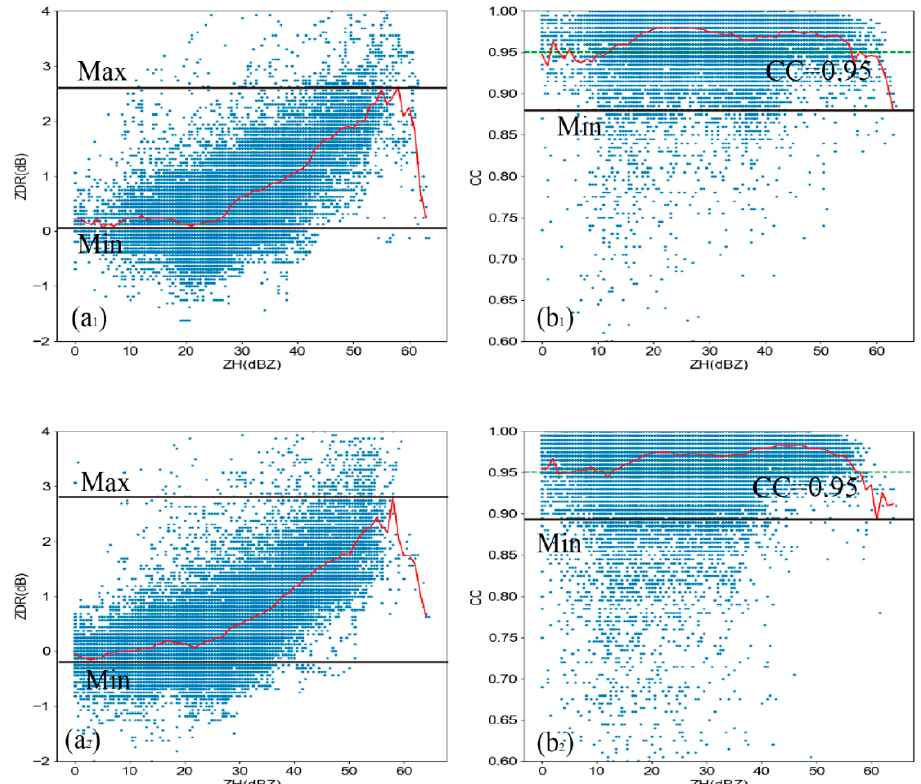
Figure 9. ( a1 , a2 ) Scatter plots of ZDR and ZH at 22:06 and 23:00 LST, respectively. ( b1 , b2 ) show the changes in CC with ZH at 22:06 and 23:00 LST, respectively. The median value is marked with a solid red line. Related data are from 1.5° elevation angle.